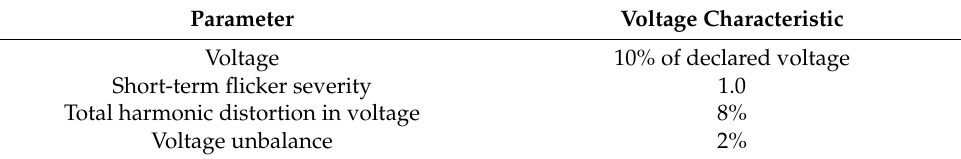
Table 1. Voltage characteristic of standard EN 50160 [43] used for the global